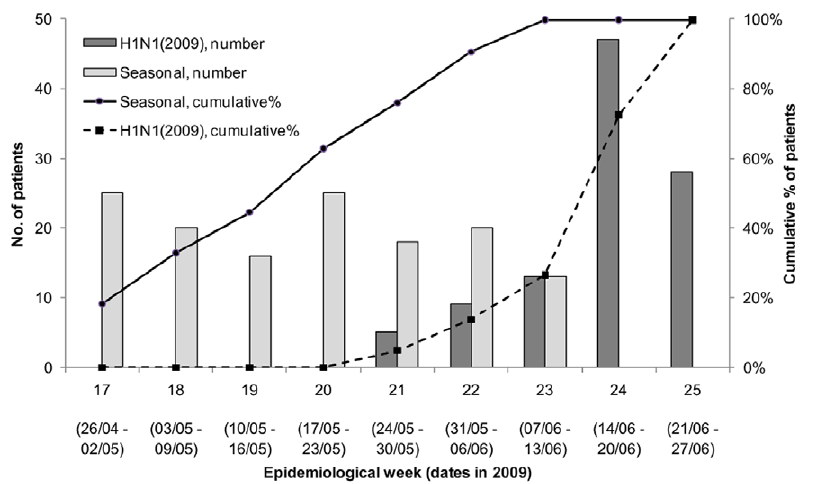
Figure 1. Date of presentation of adult H1N1(2009) andseasonal influenza cases by epidemiological week. Note that there was inconsistent testing for influenza strains other than H1N1(2009) after 11 June 2009 (Week 23), and the data for seasonal influenza is hence censored after week 23.